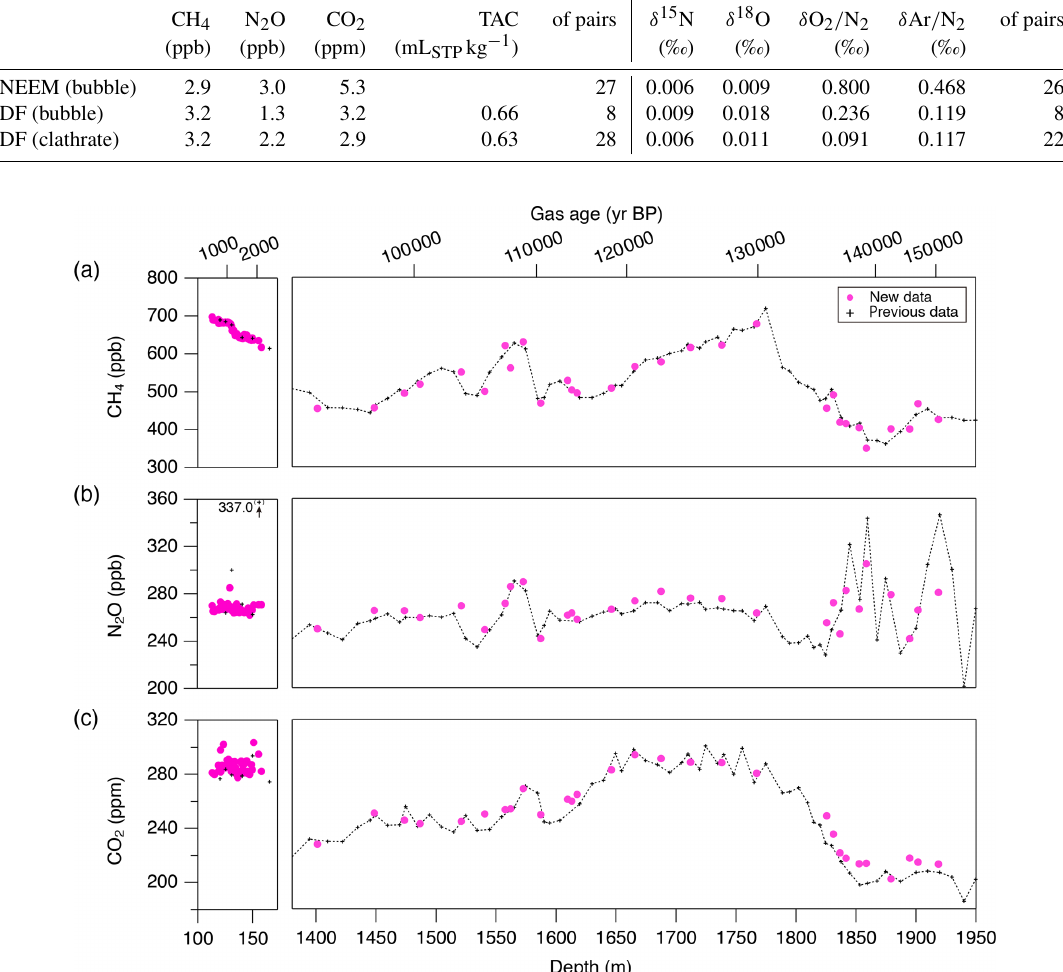
Figure 9. CH 4 , N 2 O and CO 2 concentrations of the Dome Fuji ice core, and comparison with previous records from the same core on the DFO-2006 gas age scale (Kawamura, 2001; Kawamura et al.,